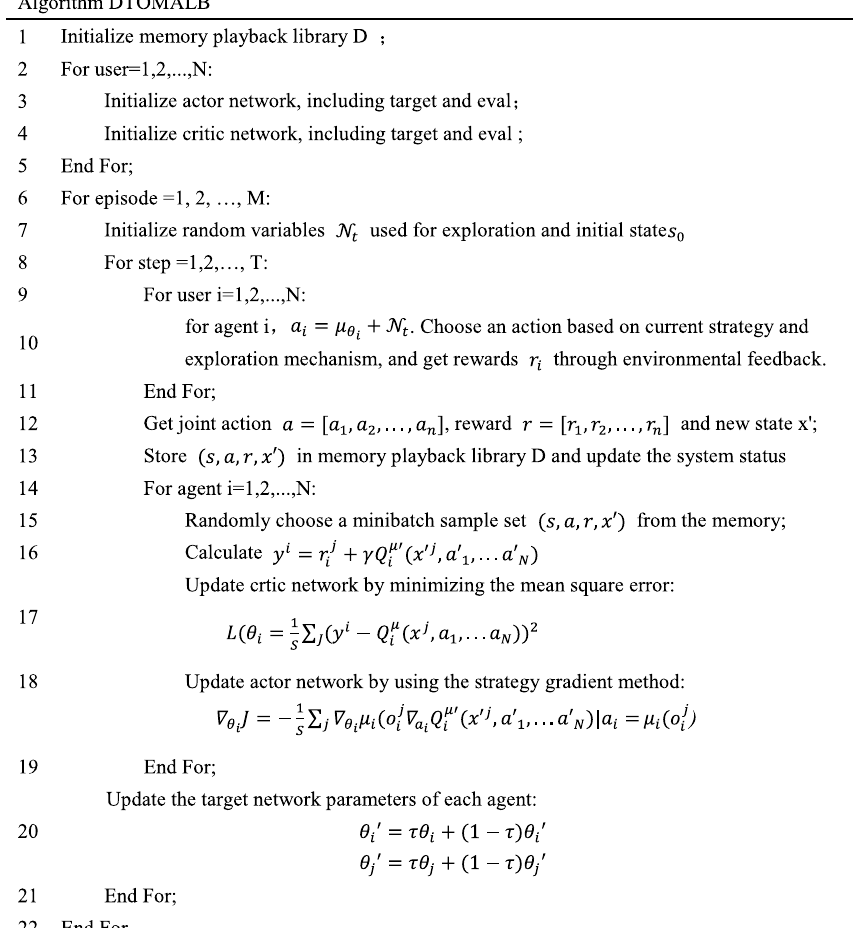
Table 1 DTOMALB algorithm